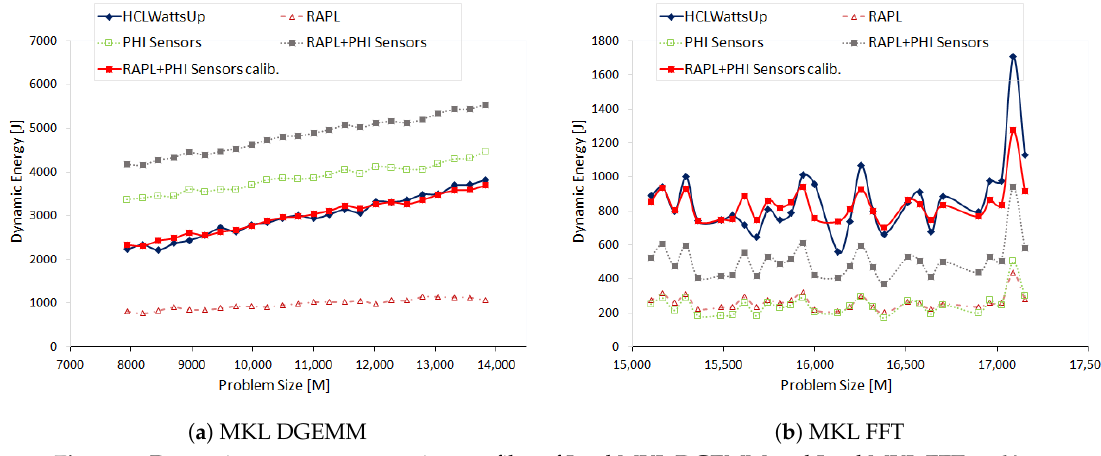
Figure 6. Dynamic energy consumption profiles of Intel MKL DGEMM and Intel MKL FFT on Xeon Phi co-processor. RAPL+PHISensors calib. means that RAPL+PHISensors values have been